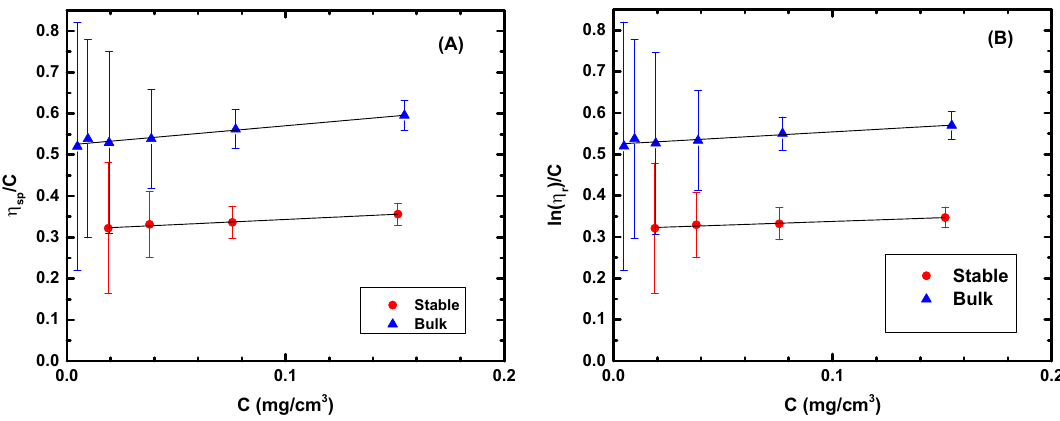
Figure 2. Intrinsic viscosity measurement results for VPD and bulk CYTOP. ( A ) Ratio of the specific viscosity ( η sp ) to concentration plotted versus concentration, with the intercept being the intrinsic viscosity. ( B ) Ratio of the natural logarithm of the relative viscosity ( η r ) to concentration plotted against concentration, with the intercept being the intrinsic viscosity. Best fit lines also shown for each data